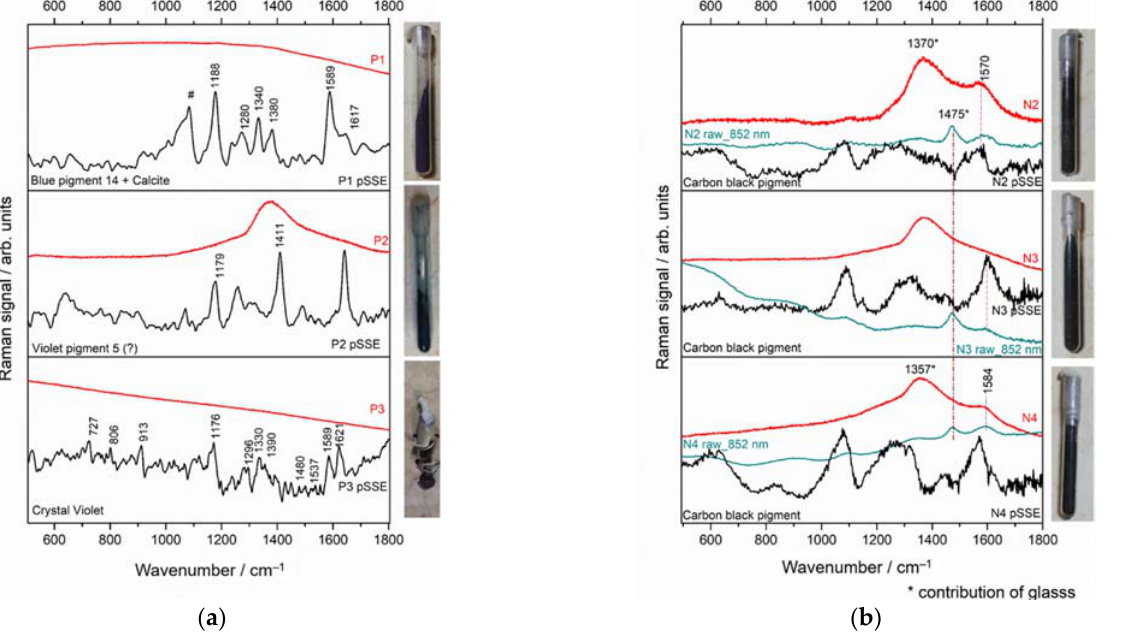
Figure 9. pSSE (black line) and dispersive (red line) RS of examined ( a ) violet (top ‐ to ‐ bottom: blue pigment + calcite, triarylmethane pigment, crystal violet); ( b ) black (carbon black) materials. The considered spectral range is 170–1800 cm − 1 . # Indicates the bands assigned to calcite.